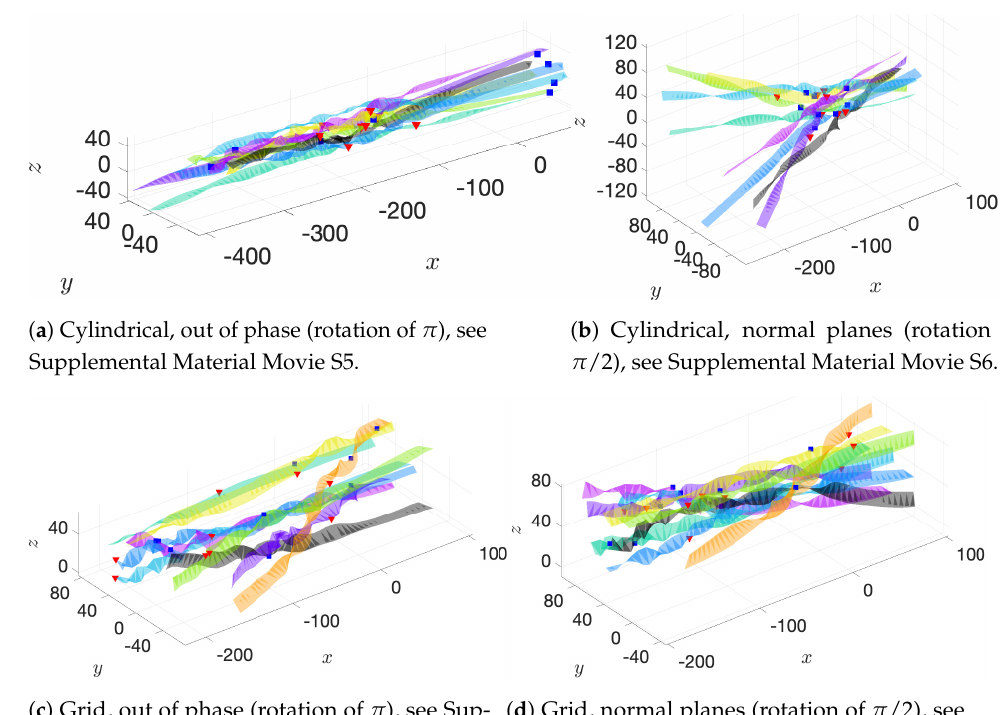
Figure 15. Phase/alignment differences between nearby neighbors, ribbon path trajectories created by triangulation of head positions over each beat for the entire simulation. Due to lateral oscillation of head within each beat, the head carves out a ribbon-like surface indicating the flagellar beat plane. Blue squares denote the location of flagellum head when maximal efficiency is achieved and red triangles denote the location of the flagellum head when minimal efficiency is achieved. Head positions started near x = 100 µ m and flagella move in the negative x -direction, so flagella heads start at far right and end up in the far left of each image. All units are in µ m. Color of curves indicates data for flagellum of matching color from initial configurations (see Figure